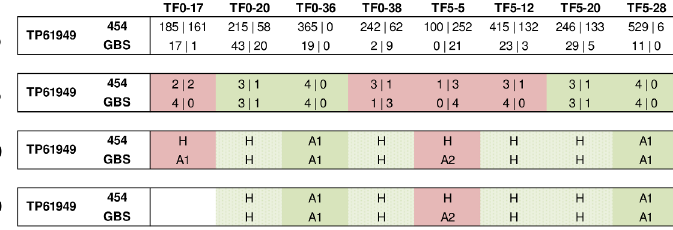
Fig 4. Example of comparison of GBS and 454 sequencing of TP61949 in eight plant samples. A) GBS and 454 read counts of each allele (A1|A2); B) predicted tetraploid allelic ratios (convergent ratios in